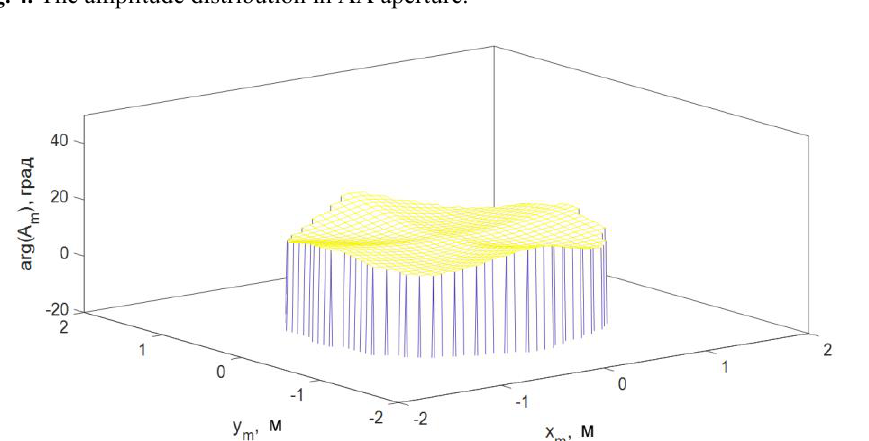
Fig. 5. The phase distribution in AA